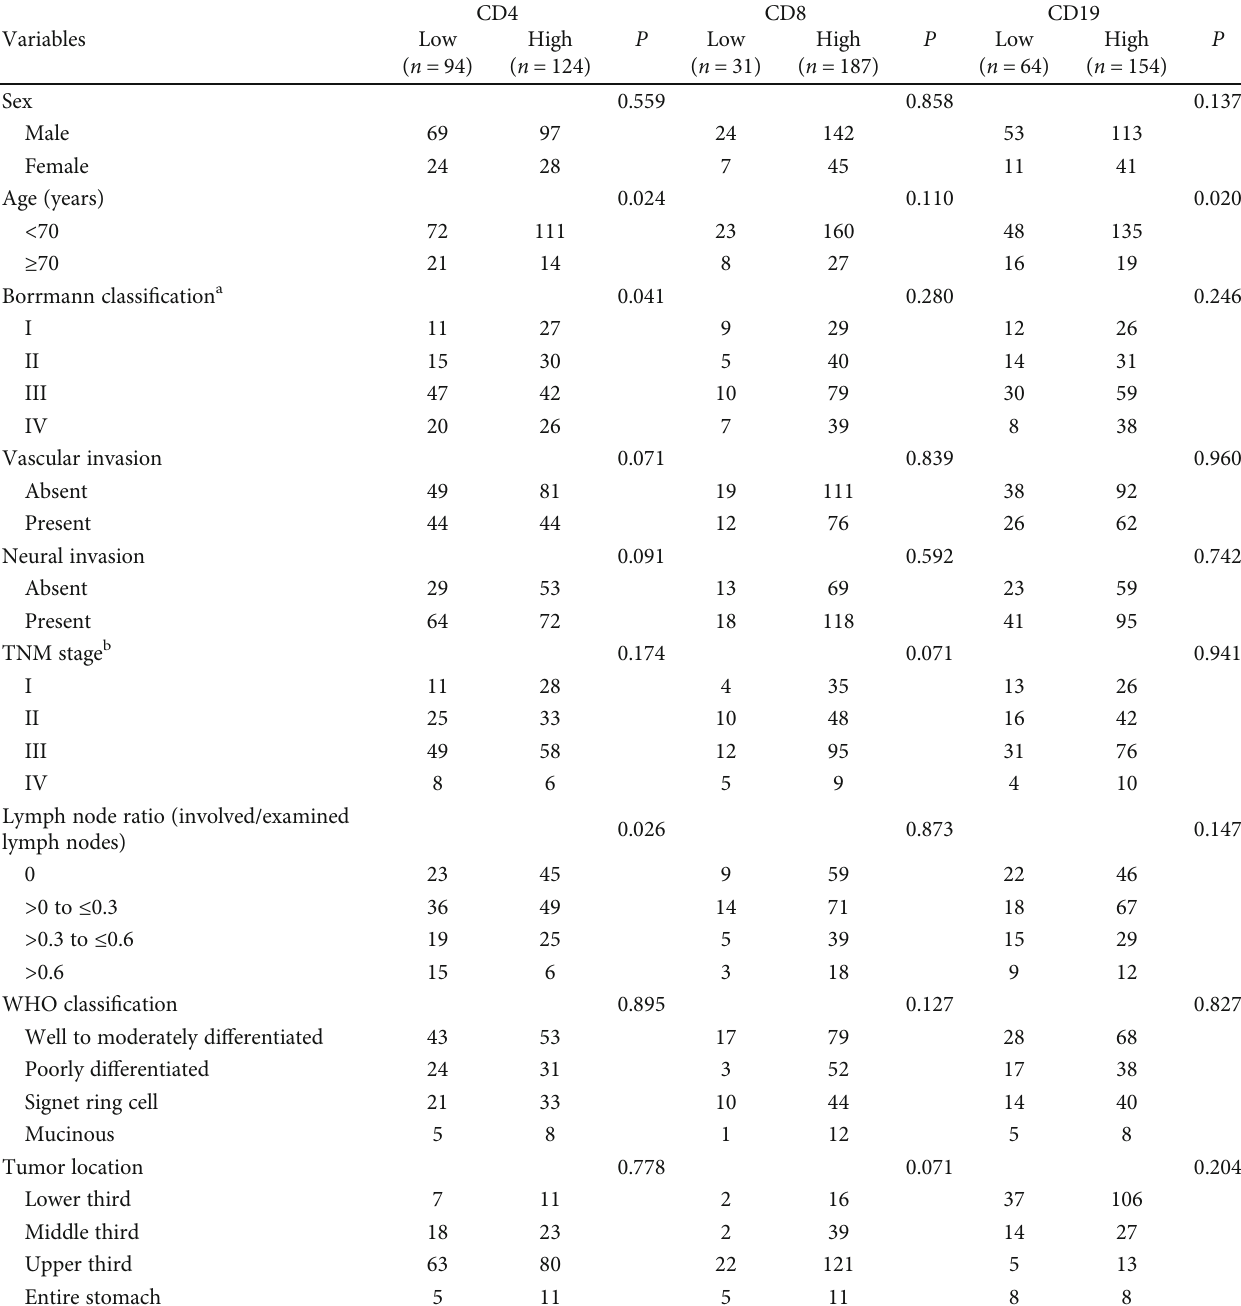
Table 2: Associations between clinicopathologic variables and systemic in fl ammatory markers in